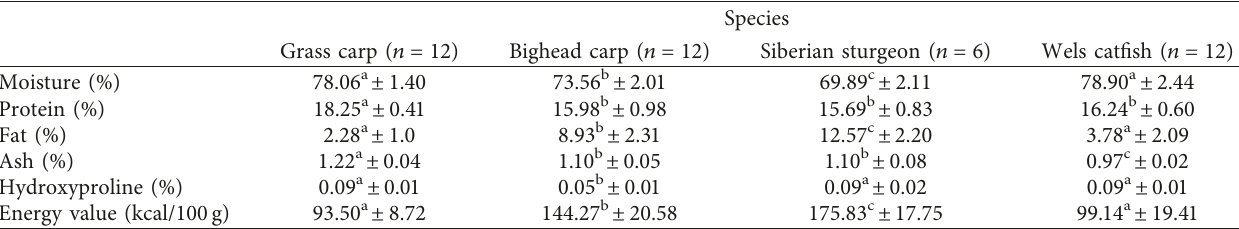
Table 2: Proximate composition, hydroxyproline level, and energy value of muscles of grass carp, bighead carp, Siberian sturgeon, and wels catfish (mean value ±